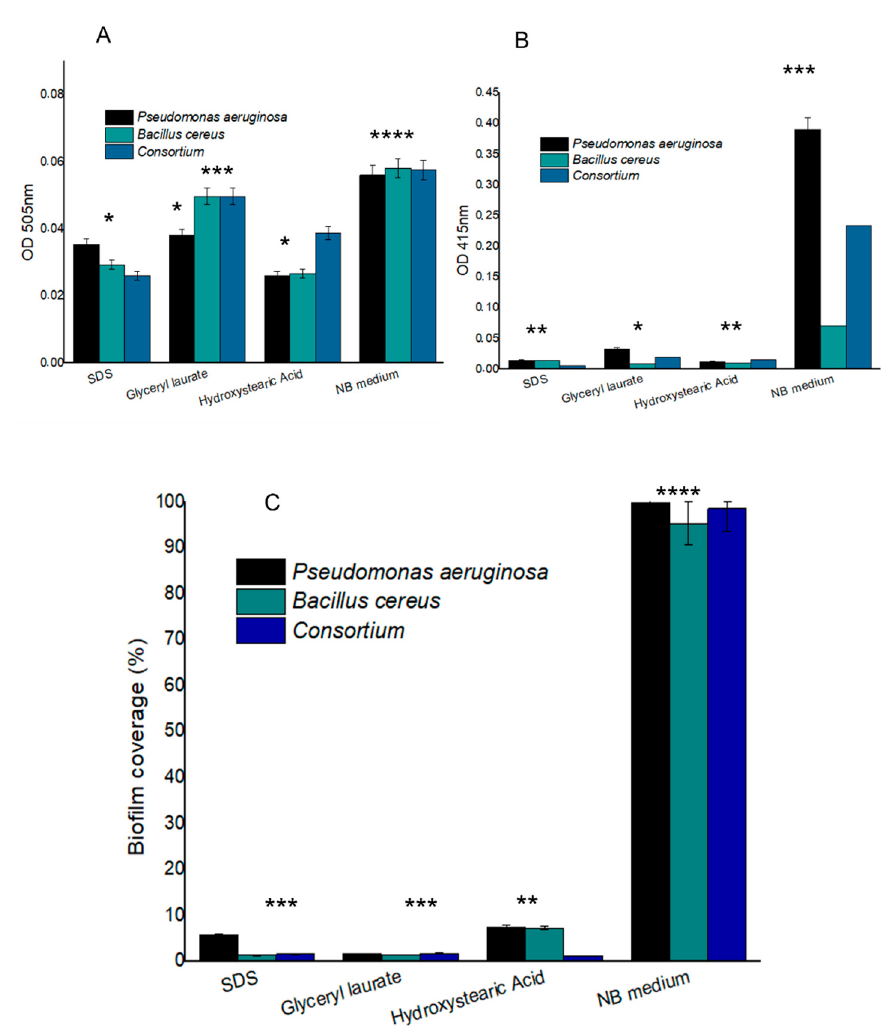
Figure 3. Bioactivity assessment of biobased surfactants on Gram-negative and Gram-positive bacteria and their consortium. ( A ) Quantification of the presence of total carbohydrates and ( B ) quantification of the presence of total proteins in a centrifuged sample without a bacterial cell by means of colorimetric enzymatic tests. ( C ) Antiadhesive test with the percentage of well cover with respect to the growth retraction of the tested microorganisms. Error bars represent 95% CI. Significant differences at a = 0.05 in Tukey’s test are indicated by a different number of asterisks above the bars.